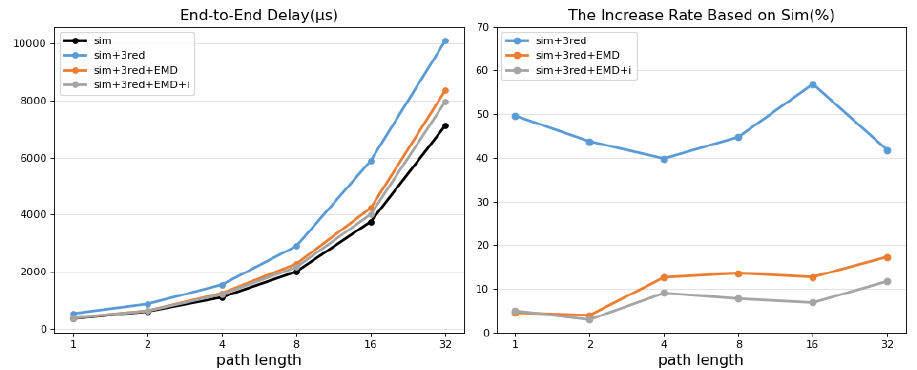
Figure 10. End-to-End Delay Test under Various Forwarding Path